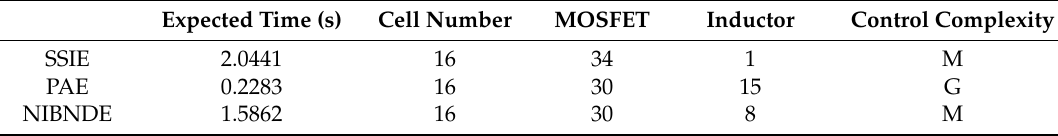
Figure 8. Sixteen cell voltage trajectories in simulation ( a ) The SSIE. ( b ) The PAE. ( c ) The NIBNDE. Table 7. The comparison between SSIE, PAE and NIBNDE in a sixteen cell battery string (G: Good; M: Marginal; P: Poor).